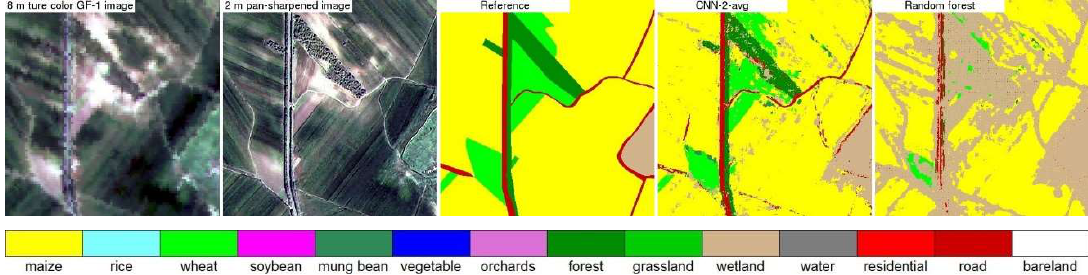
Figure 7. Study area 1 example 8 m GaoFen-1 true color image (the 400 × 400 2 m pixel box in Figure 3), 2 m pan-sharpened image, and three 2 m land cover maps (the reference land cover map, the land cover map generated by CNN model with average pooling and ~290,000 learnable parameters, and the land cover map generated by the random forest model). The two true color images are displayed using the same stretch.